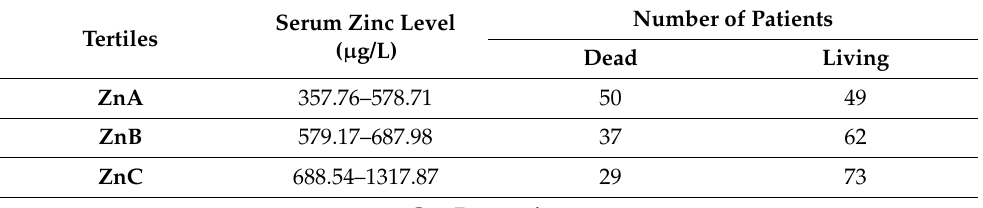
Table 2. Serum zinc level and risk of death of patients with laryngeal cancer (entire group, n = 300). Number of Patients Serum Zinc Level Tertiles ( µ g/L) Dead Living ZnA 357.76–578.71 50 49 ZnB 579.17–687.98 37 62 ZnC 688.54–1317.87 29 73 Cox Regression ZnB (37 and 62) vs. ZnC (29 and 73) HR = 1.43; CI = 0.88–2.34; p -value = 0.145 ZnA (50 and 49) vs. ZnC (29 and 73) HR = 2.32; CI = 1.47–3.69; p -value < 0.01